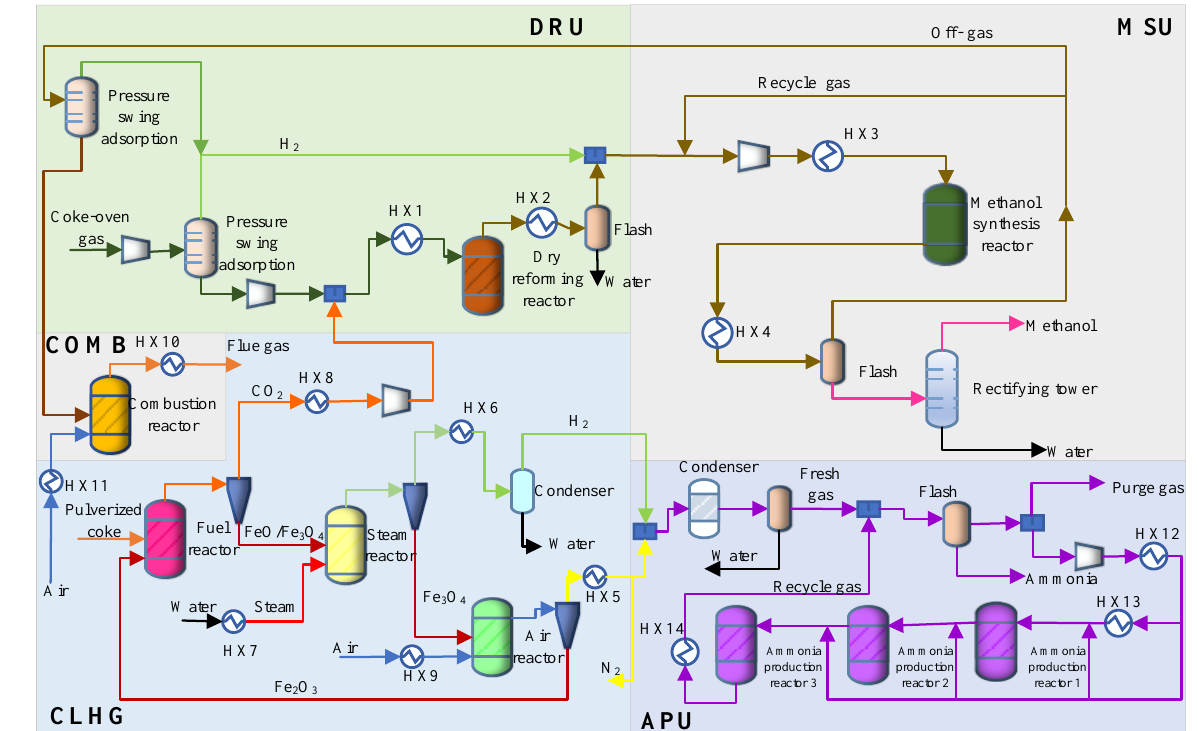
Figure 1. Schematic diagram of the PC CLHG -CGTMA process.